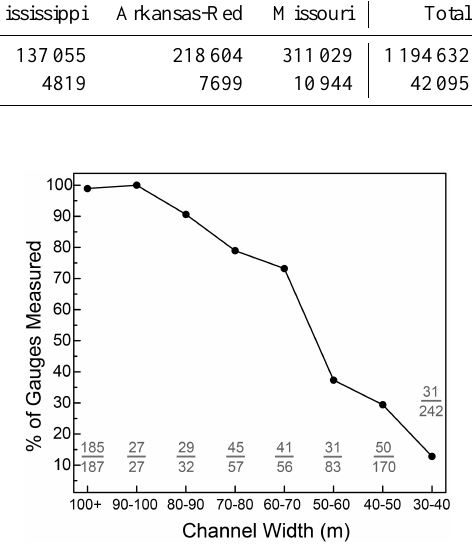
Figure 7. Percentage of USGS gauging stations measured in this study, binned by in situ channel width; gray fractions indicate num- ber measured out of total gauges per 10m width